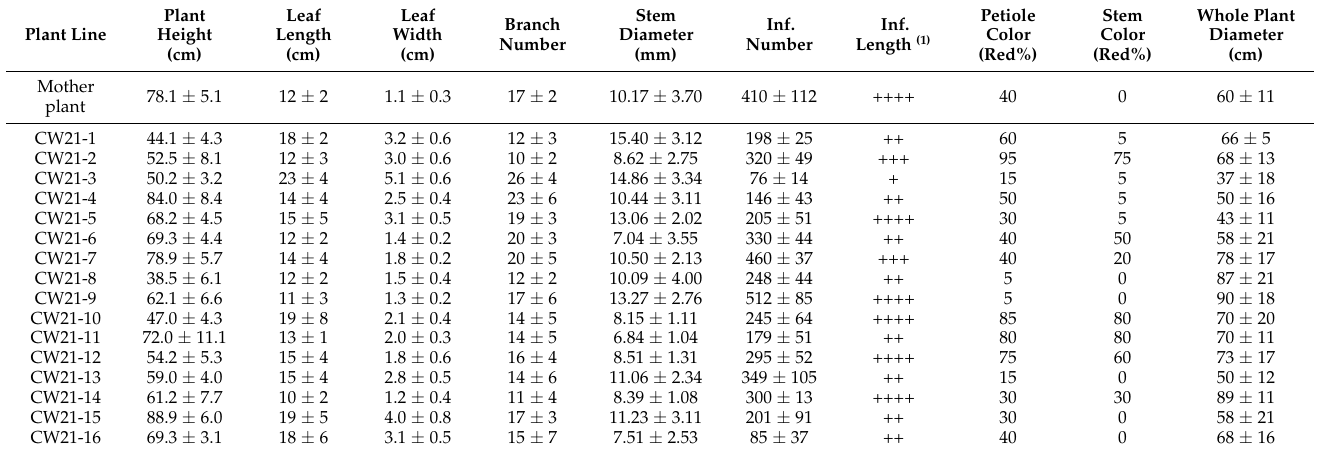
Table 3. Morphological characteristics of the Cherry Wine F1 generation.